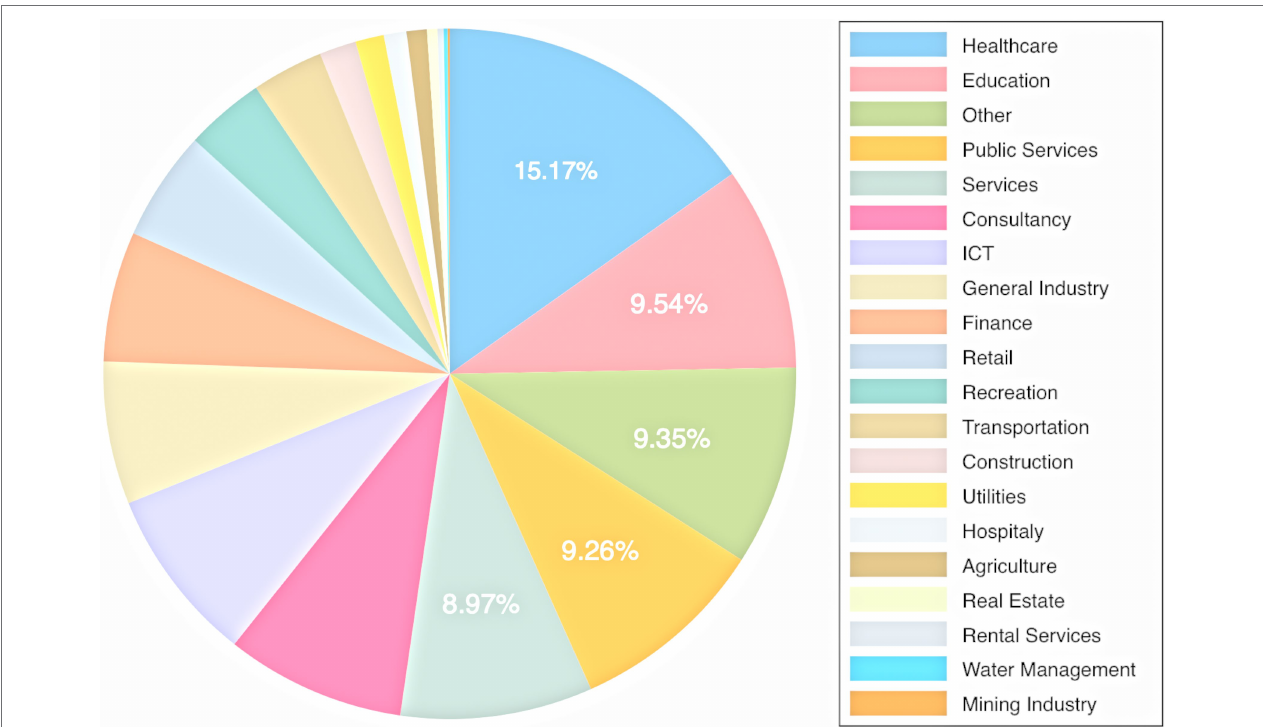
FIGURE 2 | Distribution of occupations. Note: The graph includes the percentage of respondents for the five largest groups of professions in our sample, making up for more than half our sample. Note that healthcare professions in our Dutch sample include “well-being” (“zorg en welzijn”), which is a broader category than purely healthcare professionals. This also includes massage therapists and physiotherapist, for